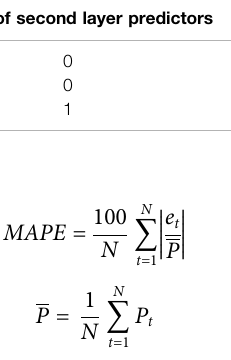
TABLE 5 | Summary of the model structure and training time of three forecasting models. Forecasting